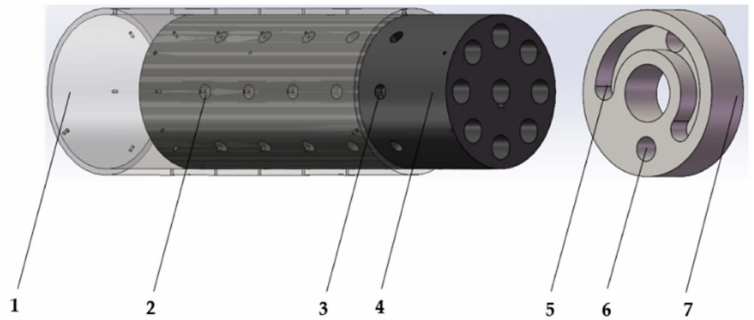
Figure 3. The cylinders and ventilation chamber shell. 1. Outer cylinder; 2. Outer suction holes; 3. Inner cylinder; 4. Inner suction holes; 5. Negative-pressure zone; 6. Positive-pressure zone; 7. Ventilation chamber shell.